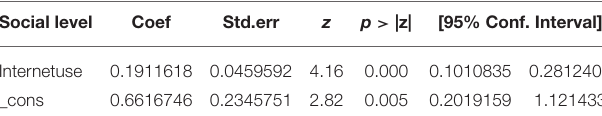
TABLE 7 | The relationship between insurance participation and